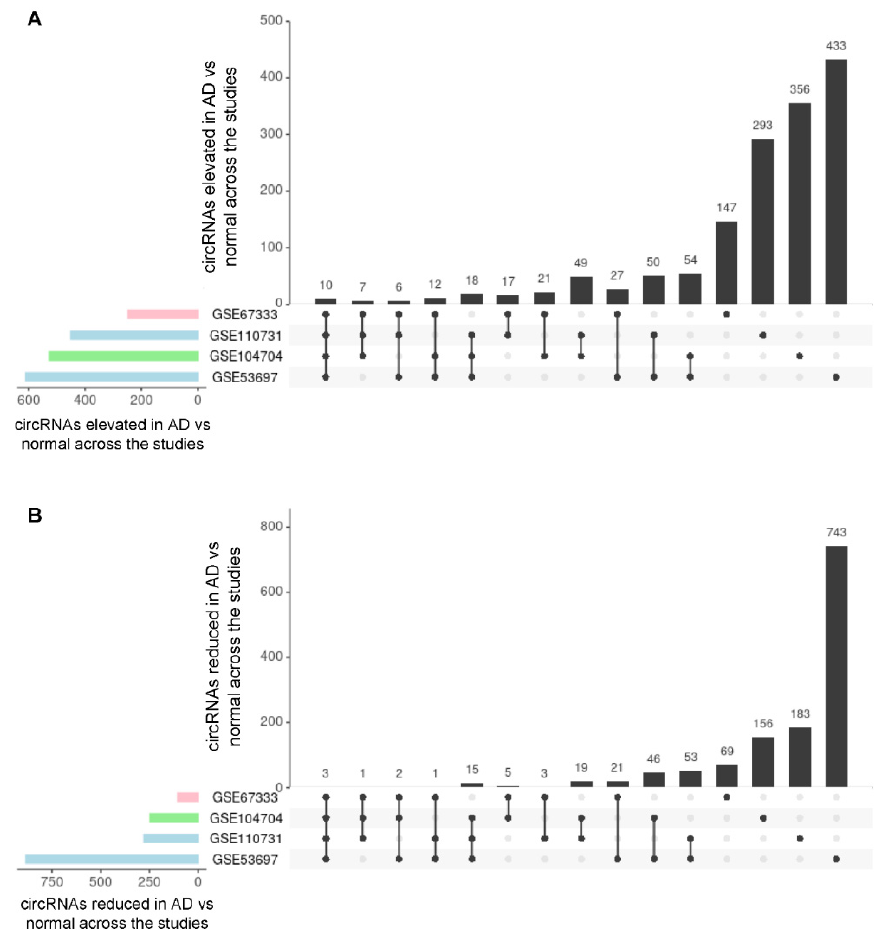
Figure 3. Shared circRNAs differentially expressed across studies . Each bar and corresponding filled in dots below represent the number of circRNAs more highly abundant in AD than control ( A ) and less abundant in AD than control ( B ) and the studies in which they were found (see also Supple- mental Table S1). For example, in ( A ) 10 circRNAs were elevated across all four studies; in ( B ) only 3 circRNAs were less abundant in all four studies (see also Supplemental Table